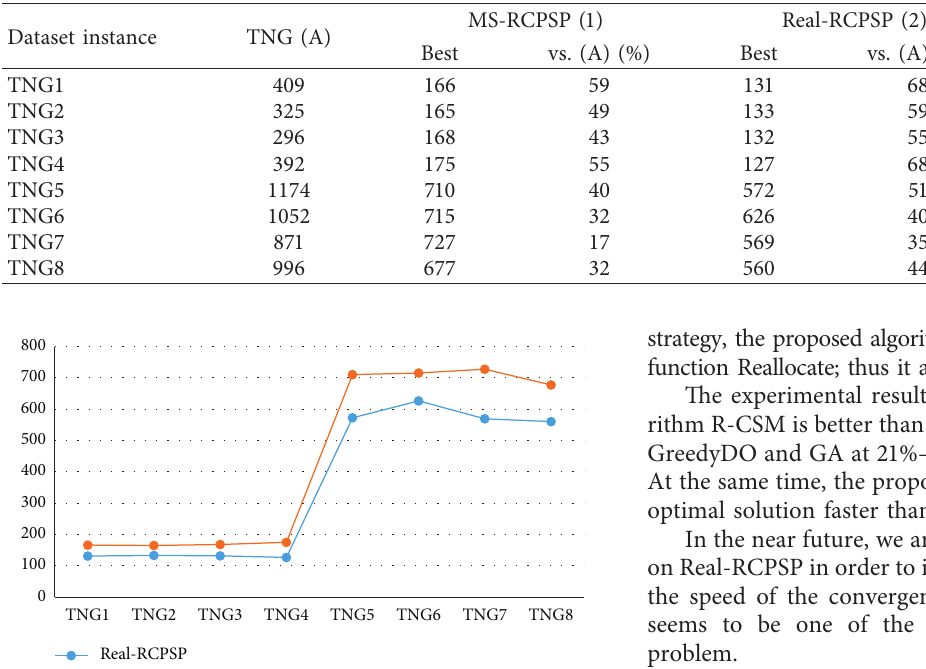
Table 12: Experimental results with Real-RCPSP.